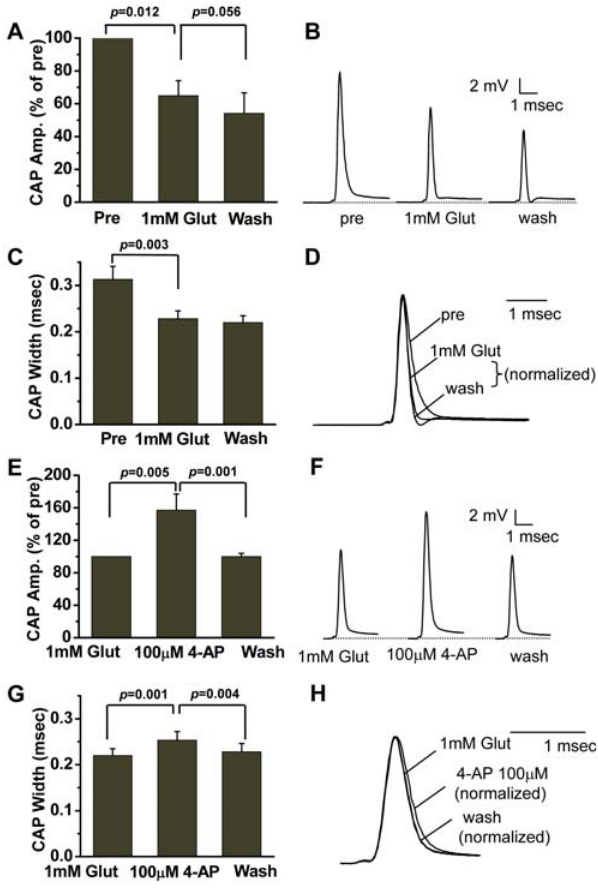
Figure 3. Effect of glutamate (Glut) and 4-AP on CAPs in exvivo spinal ventral columns. (A) Histogram showing an irreversible increase in mean peak CAP amplitudes (normalized to 100% of the CAP amplitude (Pre) prior to glutamate treatment) after 1 mM glutamate treatment. (B) Representative CAP recordings before and after glutamate treatment and washing. (C) Histogram showing a decrease in CAP widths at half amplitude after glutamate treatment. (D) Representative CAP recordings showing a width decrease after glutamate treatment. The CAP amplitudes were normalized to the same level of pre-glutamate treatment (Pre) in order to compare CAP widths at half amplitude. (E) Histogram showing an increase in mean peak CAP amplitudes (normalized to 100% of the CAP amplitude (1 mM Glut) after glutamate treatment and washing) after 100 m M 4-AP treatment. (F) Representative CAP recordings before and after 4-AP treatment. (G) Histogram showing an increase in CAP widths at half amplitude after 4-AP treatment. (H) Representative CAP recordings showing a width increase after 4-AP treatment. The CAP amplitudes were normalized to the same level of that before 4-AP treatment (1 mM Glut, after glutamate treatment and washing) in order to compare CAP widths at half amplitude. In all cases, a paired Student’s t -test was used to compare measurements between two groups ( n =6).